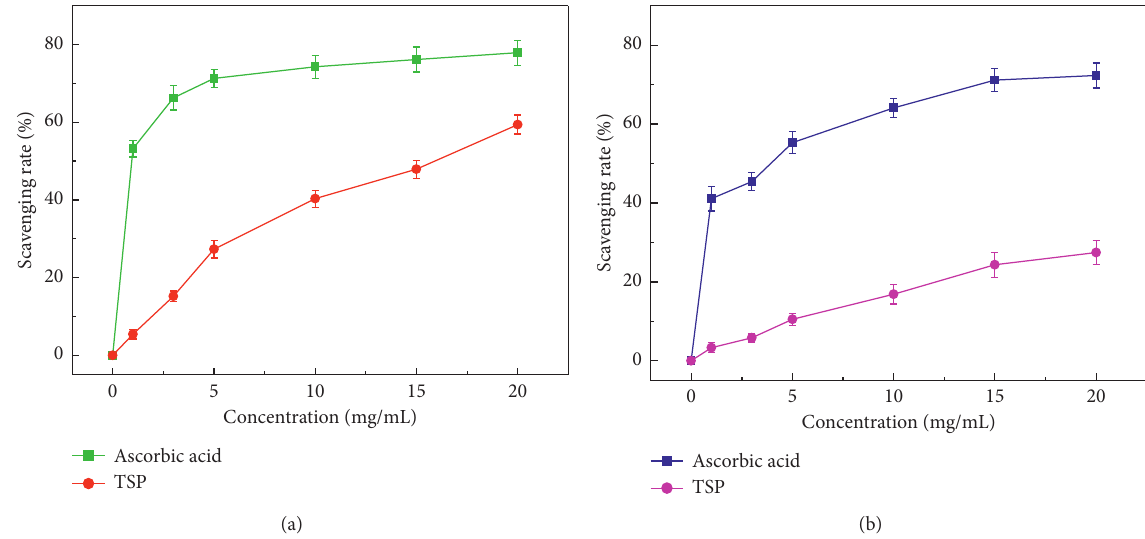
Figure 7: Antioxidant activity of TSP in vitro : (a) scavenging rate on DPPH radical and (b) scavenging rate on hydroxyl radical. Statistical significance level of p < 0.05 calculated by Duncan’s